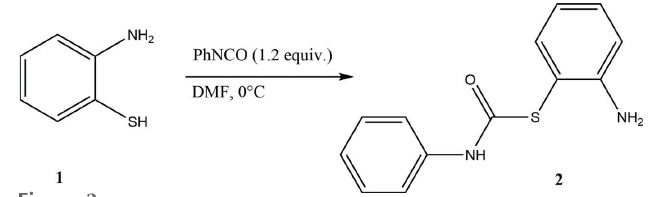
Figure 3 Reaction scheme.